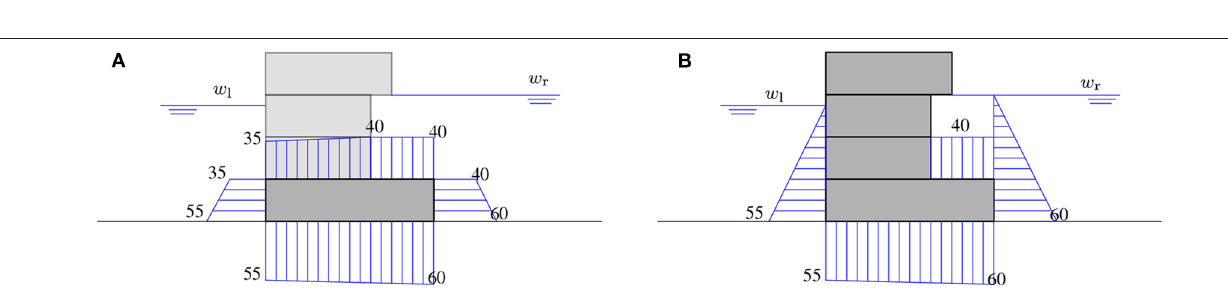
FIGURE 3 | Enclosed soil (hatched) for a number of wall layouts, where the dot indicates the block for which equilibrium is considered.